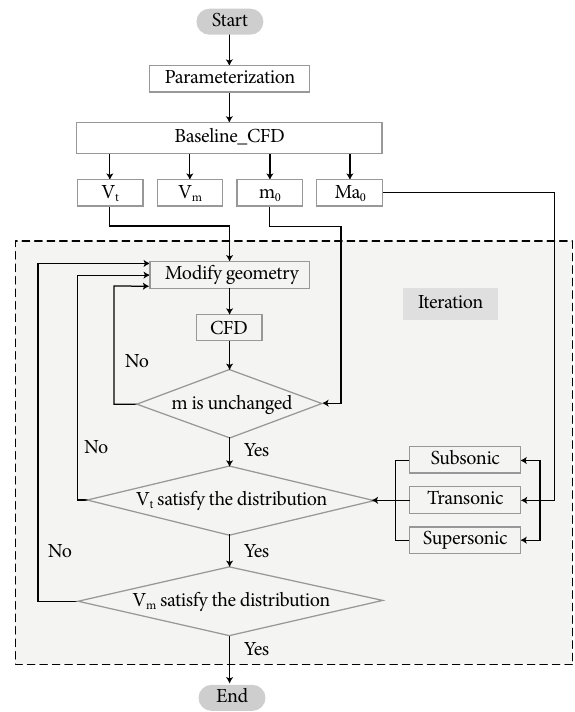
Figure 21: Optimization design